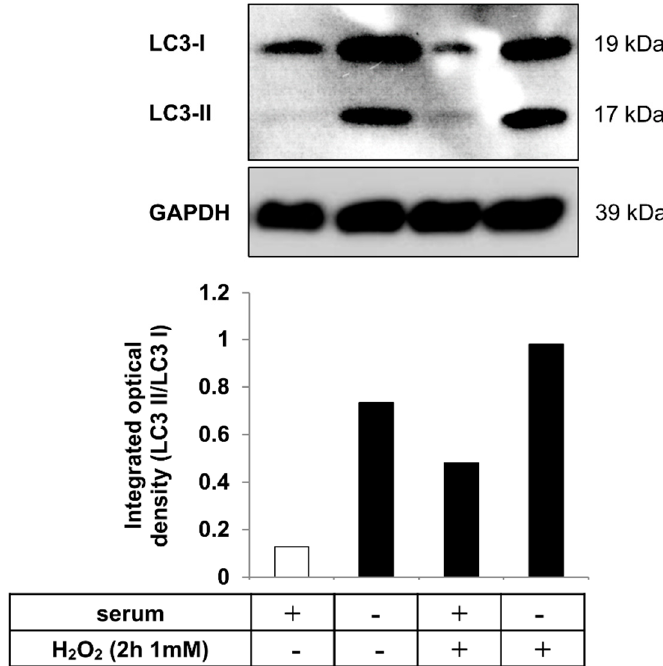
Figure 3. Autophagy induction as a result of serum deprivation and H 2 O 2 co-treatment in hESC-RPE cells. Representative western blot image for the expression of LC3 in hESC-RPE cells treated with 1 mM H 2 O 2 for 2 h in the presence or absence of serum. Integrated optical density was determined by densitometry for quantification of the LC3-II/LC3-I ratio using the ImageJ software. GAPDH was used as a loading control. Data are representative of three independent experiments.